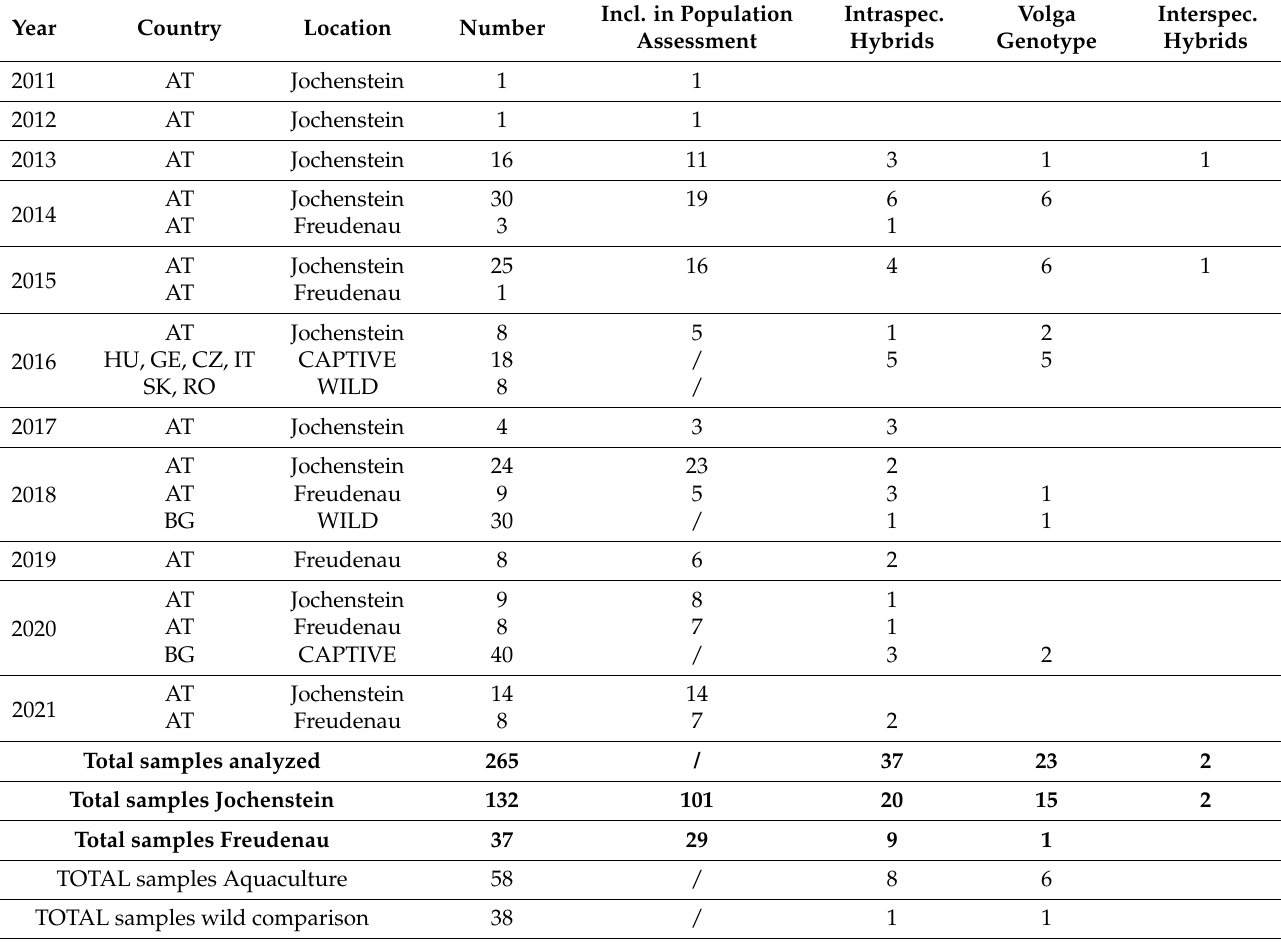
Table 1. Total number of samples analyzed for both populations, with year of sampling and samples used as comparative material (light), as well as the number of individuals included in the population assessments and detected numbers of intraspecific, interspecific, and Volga genotypes. Intraspecific hybrids below the 25% threshold are also included in the population